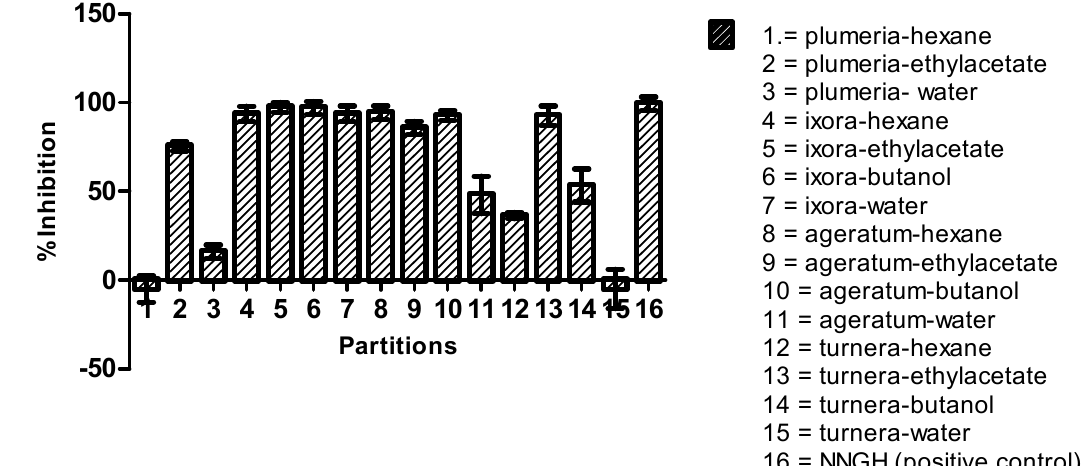
Figure 3. The histogram of inhibition percentage from 15 partitions from methanol extract of each plant measuredbyFRET-basedassayagainstMMP9activityin vitro. N -isobutyl- N -(4-methoxyphenylsulfonyl)-glycyl hydroxamic acid (NNGH) was used as the positive control by showing 100% inhibition at 1 µ M. The bars described the standard error of triplicate assay.